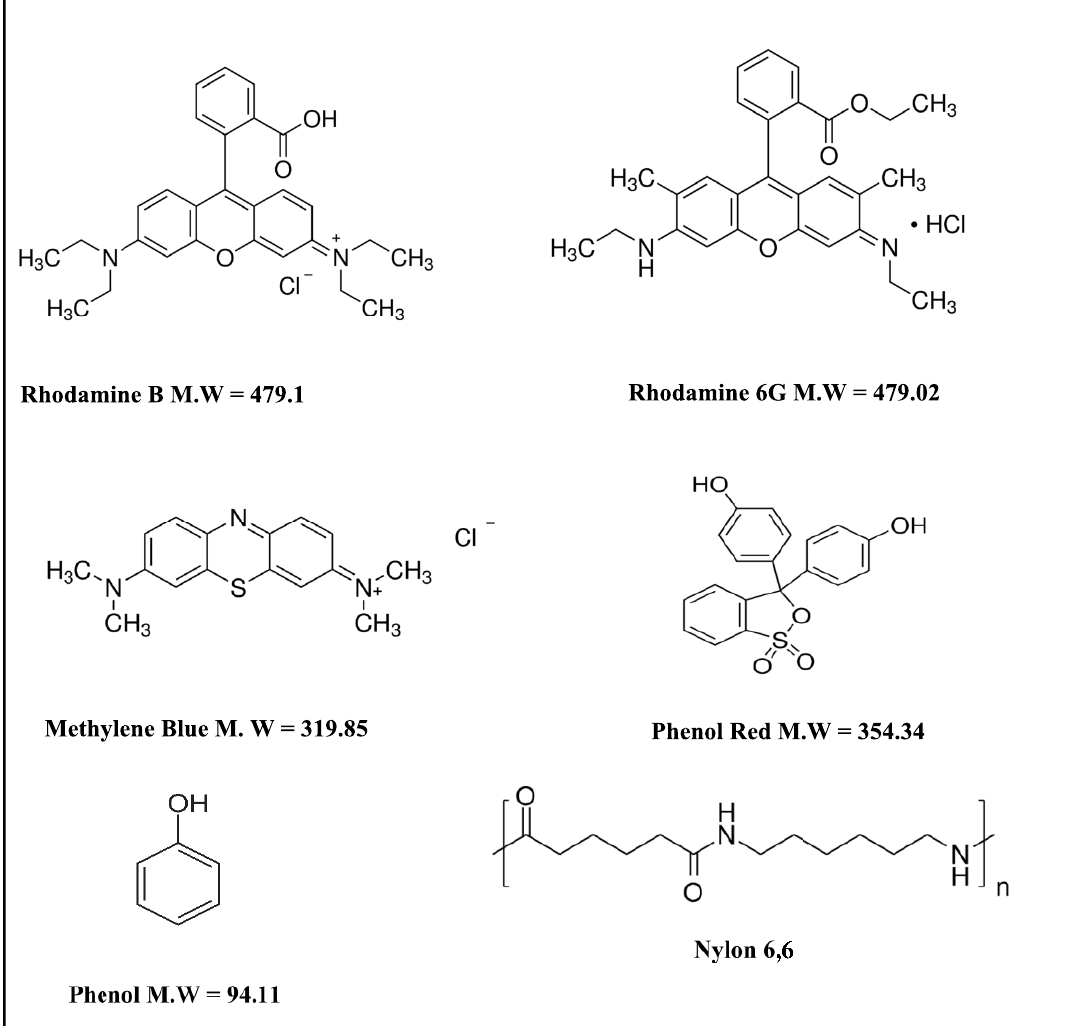
Figure 1. Chemical structure of the investigated probes and of nylon 6,6.